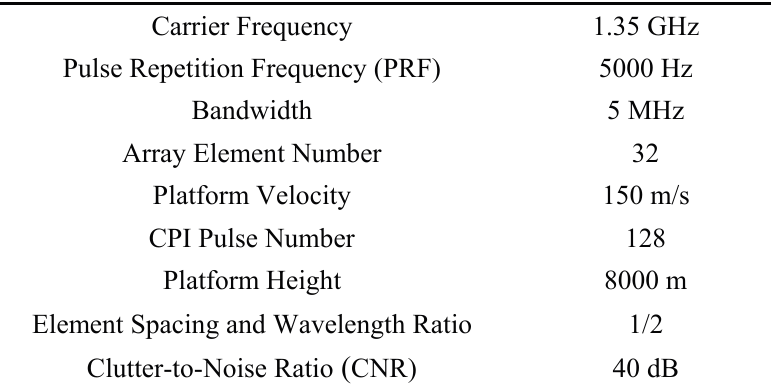
Table 1. Simulation Parameters for airborne early warning (AEW)